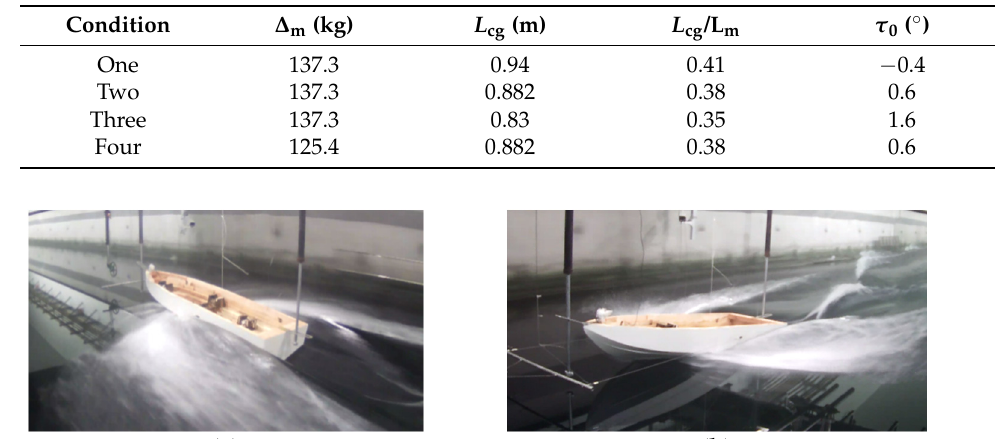
Figure 4. Photographs of the monomer-form model.